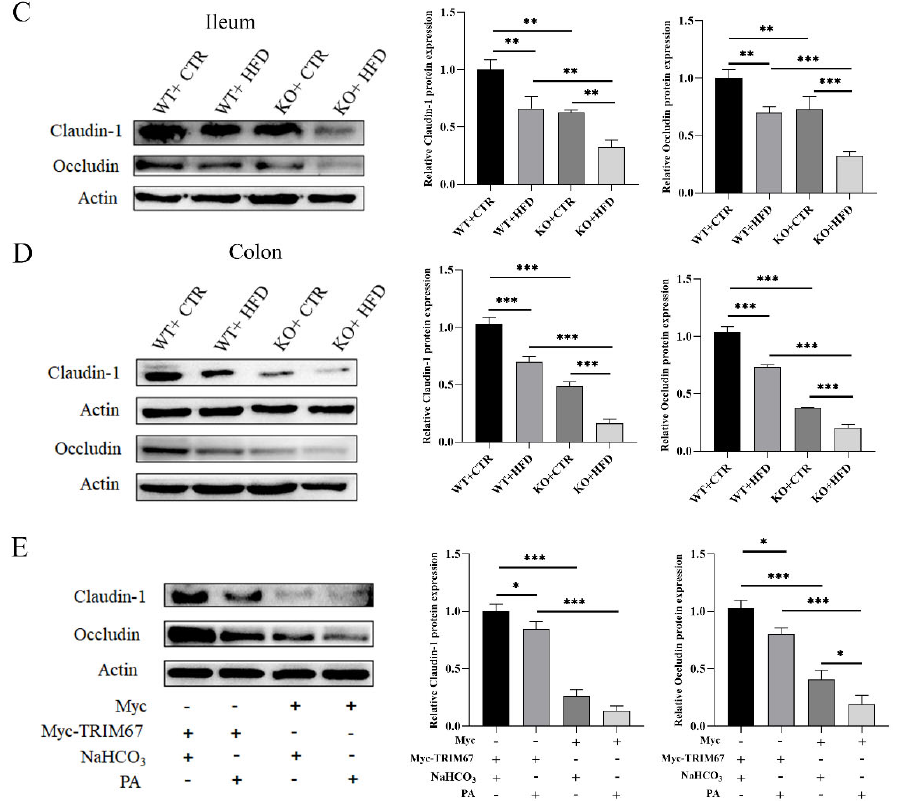
Figure 3. Knockout of TRIM67 decreases the expression of tight junction proteins and HFD exacer ‐ bate the intestinal barrier damage. ( A ) The relative mRNA expression of claudin ‐ 1 ( n = 5), occludin ( n = 4) and ZO ‐ 1 ( n = 4) in ileum, and ( B ) The relative mRNA expression of claudin ‐ 1 ( n = 4), occludin ( n and ZO-1 ( n = 4) in colon. ( C , D ) Western blots and quantification of claudin-1 and occludin in ileum = 5) and ZO ‐ 1 ( n = 4) in colon. ( C , D ) Western blots and quantification of claudin ‐ 1 and occludin in ileum and colon ( n = 3). ( E ) Detection of claudin ‐ 1 and occcludin protein and quantification in Myc ‐ TRIM67 and Myc cell lines supplemented with NaHCO 3 and PA, “ ‐ ”: no addition, “+”: addition ( n and Myc cell lines supplemented with NaHCO 3 and PA, “-”: no addition, “+”: addition ( n = 3). The = 3). The data are expressed as mean ± SEM. Significance was determined by one ‐ way ANOVA (* p data are expressed as mean ± SEM. Significance was determined by one-way ANOVA (* p < 0.05, < 0.05, ** p < 0.01, *** p < 0.001). ** p < 0.01, *** p < 0.001).